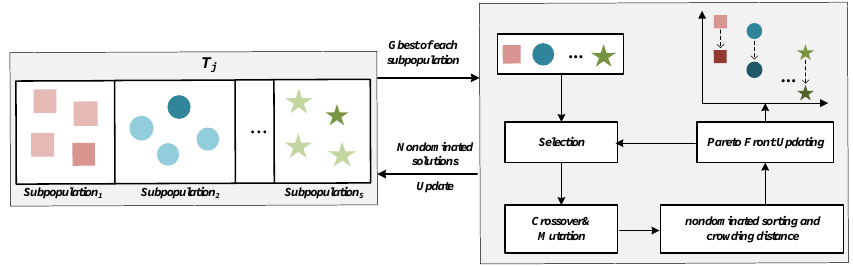
Figure 3. The illustration of the Local Exploration Strategy with